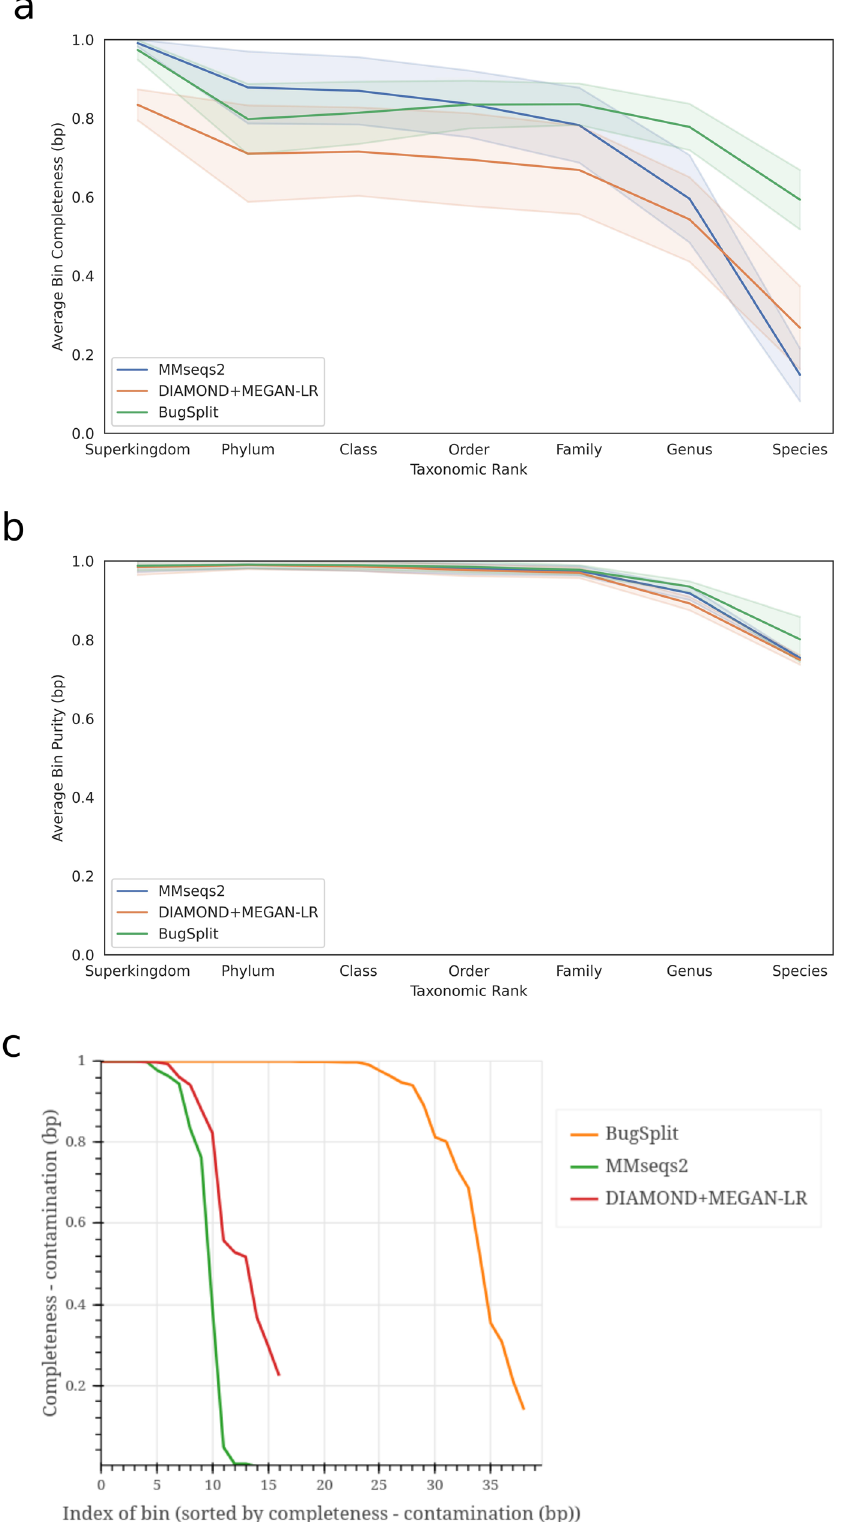
Fig. 2 Performance of contig taxonomic classi fi ers across four datasets (Zymo Even, Zymo Log, Zymo Gut, and CAMI high complexity). a Average bin completeness across taxonomic ranks. b average purity across taxonomic ranks. Shaded bands show the standard error of the metrics in a and b . c BugSplit produces more complete bins with less contamination compared with alternative taxonomic